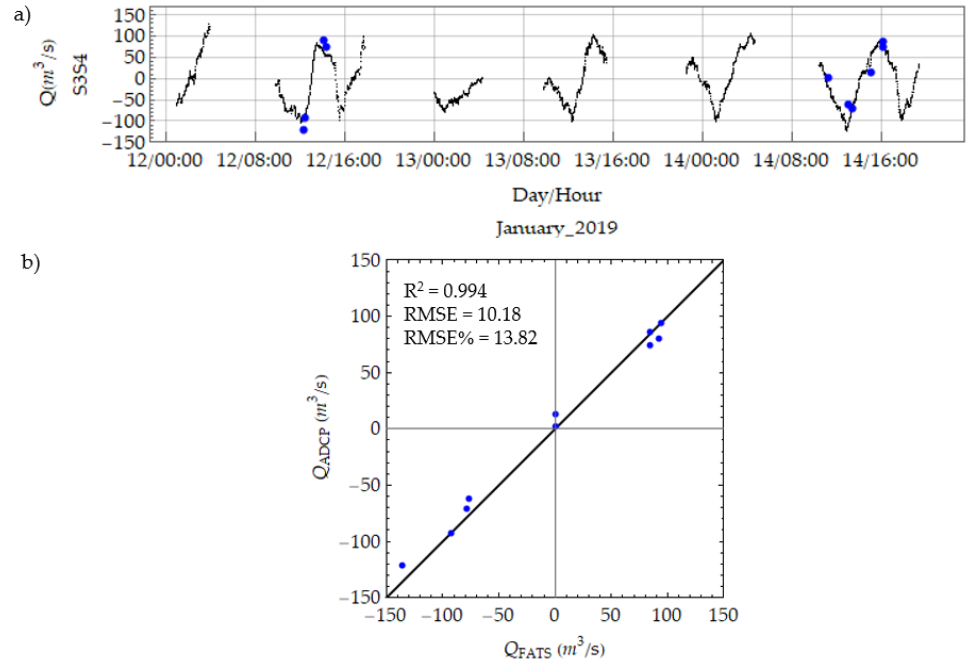
Figure 6. ( a ) Comparison of the discharges acquired using the FAT (black) and ADCP (blue) and ( b ) The association between the FAT and ADCP estimates.